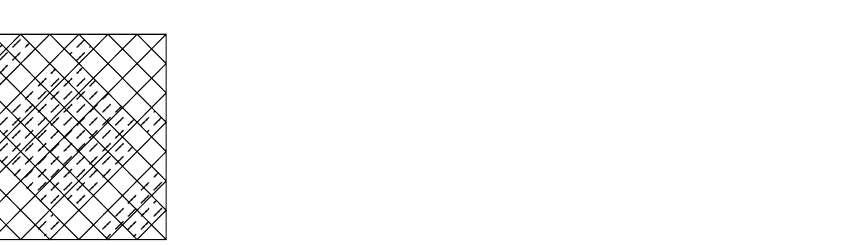
Figure 15. PCR of the second structure for different relaxation time of graphene.